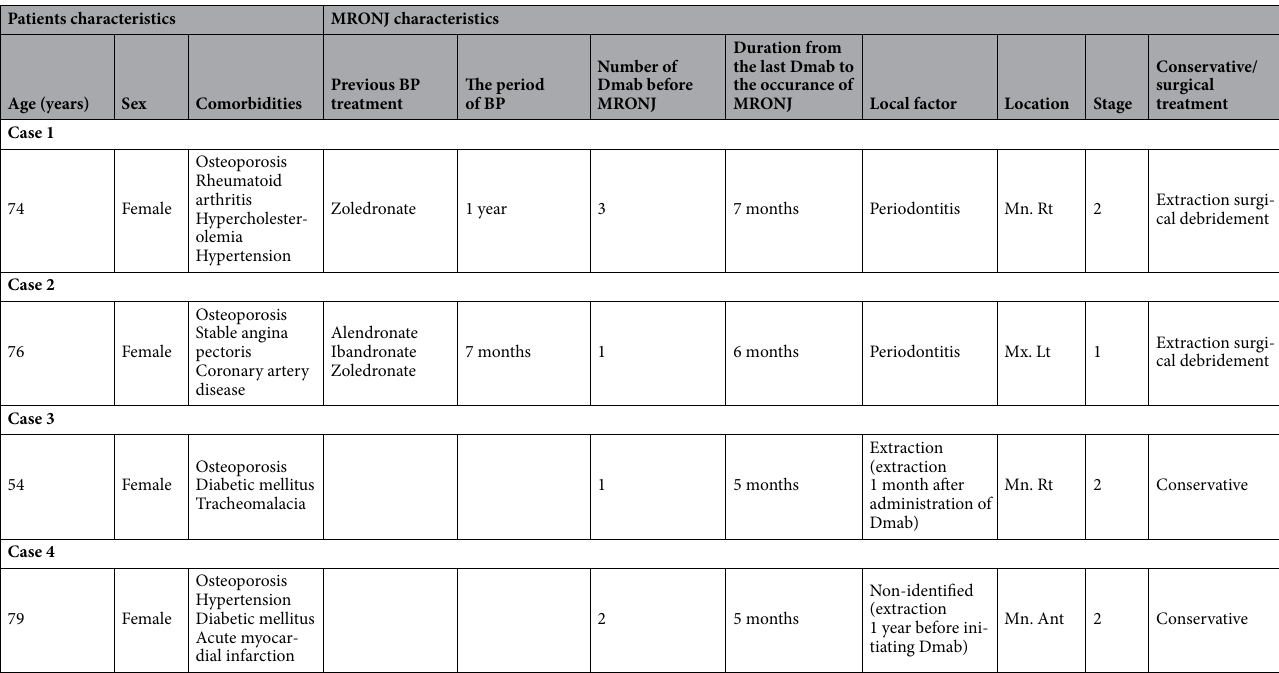
Table 5. Case description of MRONJ of osteoporosis patient treated with denosumab. BP bisphosphonate, Dmab denosumab, MRONJ medication-related osteonecrosis of the jaw, Mn Mandibular, Mx Maxillary, Rt Right, Lt